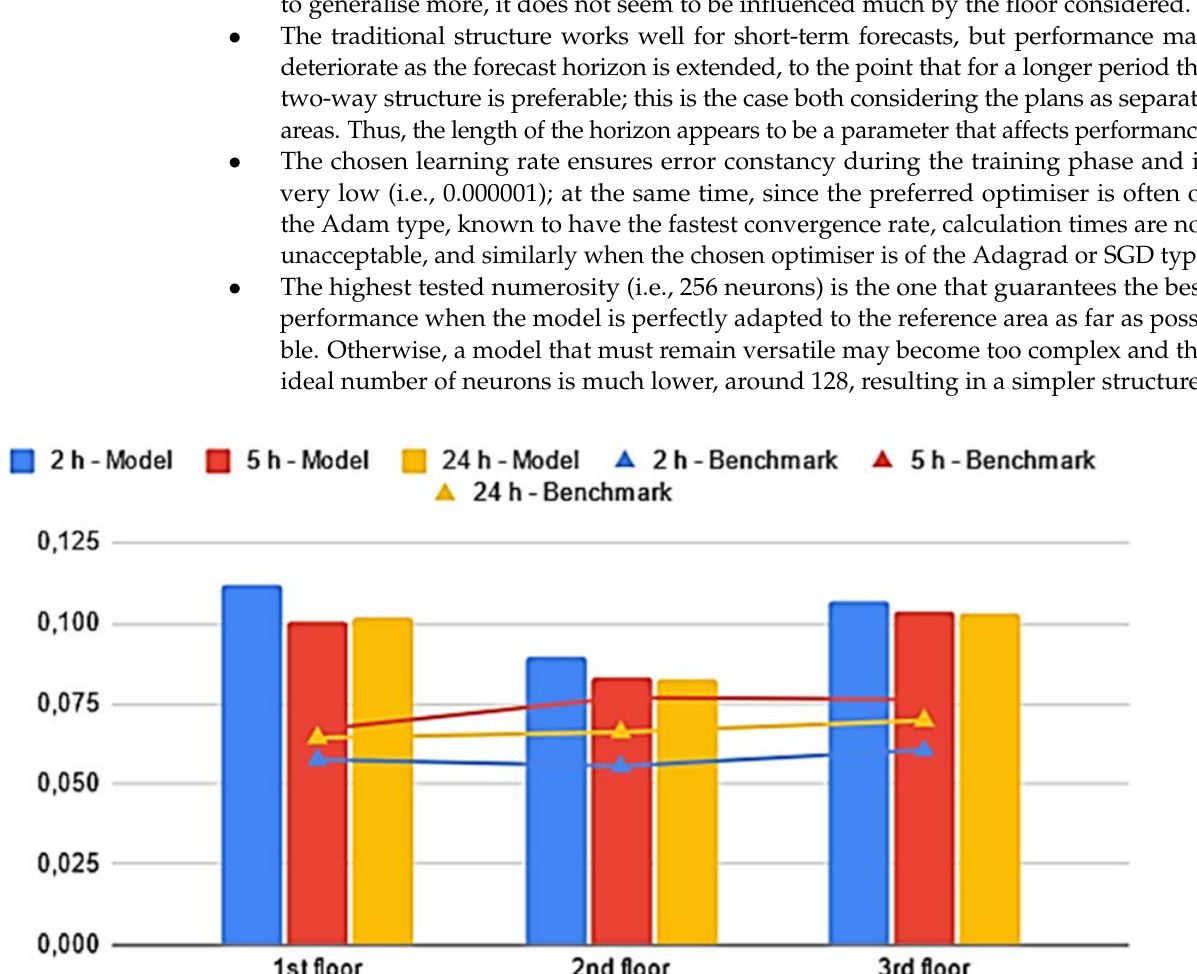
Figure 30. Average RMSE concerning floor for the validation set.